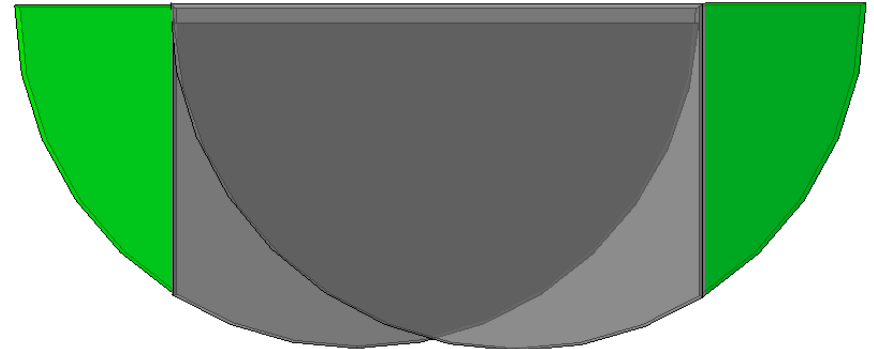
Figure 12. Cell partitioning strategy for definition of the boundary conditions applied on the green regions.